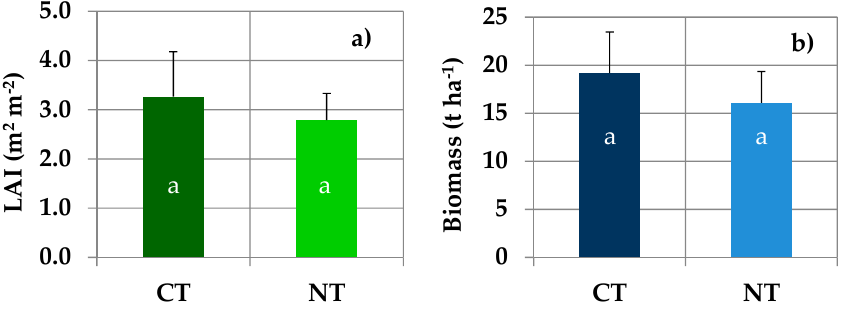
Figure 10. Leaf area index (LAI) ( a ) and fresh biomass ( b ) measured at Gravina site. Bars represent standard deviations. For each diagram, values followed by the same letter are not significantly different according to a two-tailed t -test ( p = 0.05).